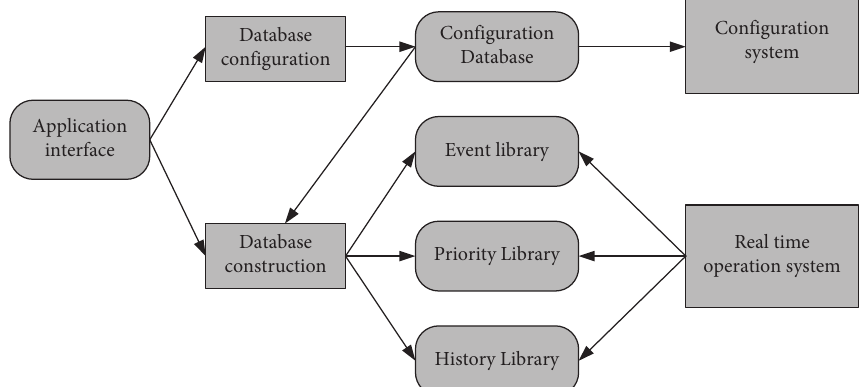
Figure 5: Structure diagram of the real-time database of an electrical monitoring system.